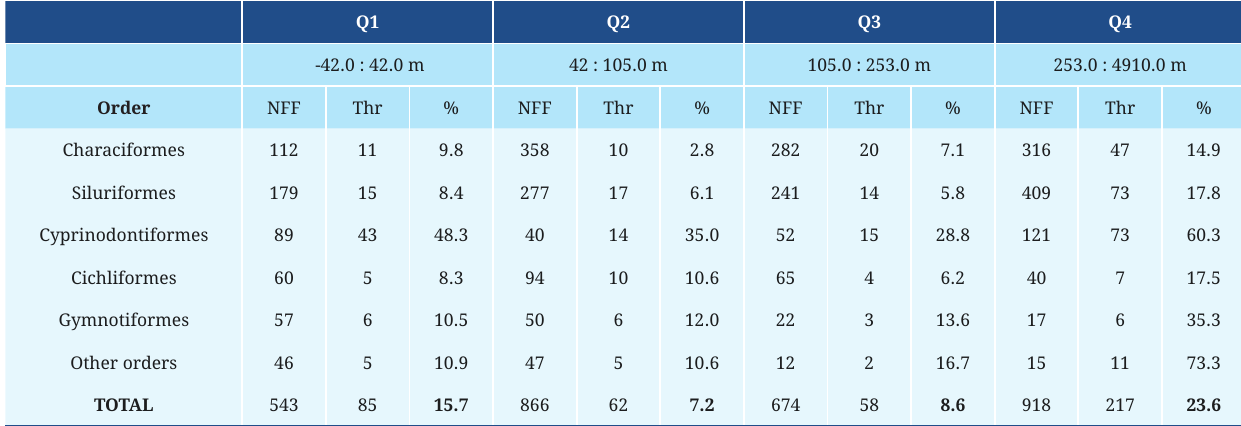
TABLE 4 | Summary of the IUCN–RL data for 3,001 NFF species, with estimates of median elevation within interquartile ranges. Thr = Threatened species.